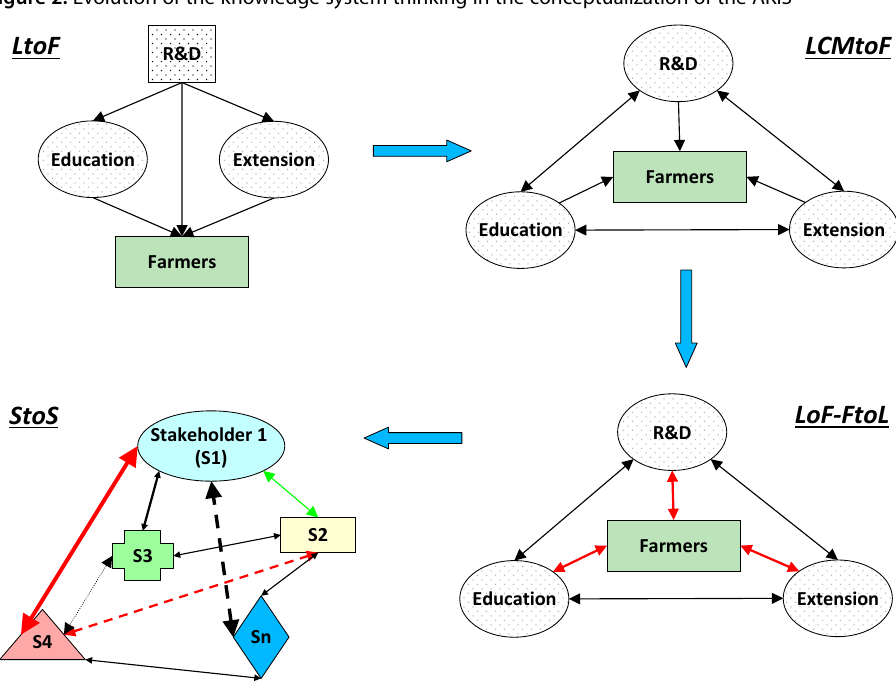
Figure 2. Evolution of the knowledge system thinking in the conceptualization of the AKIS